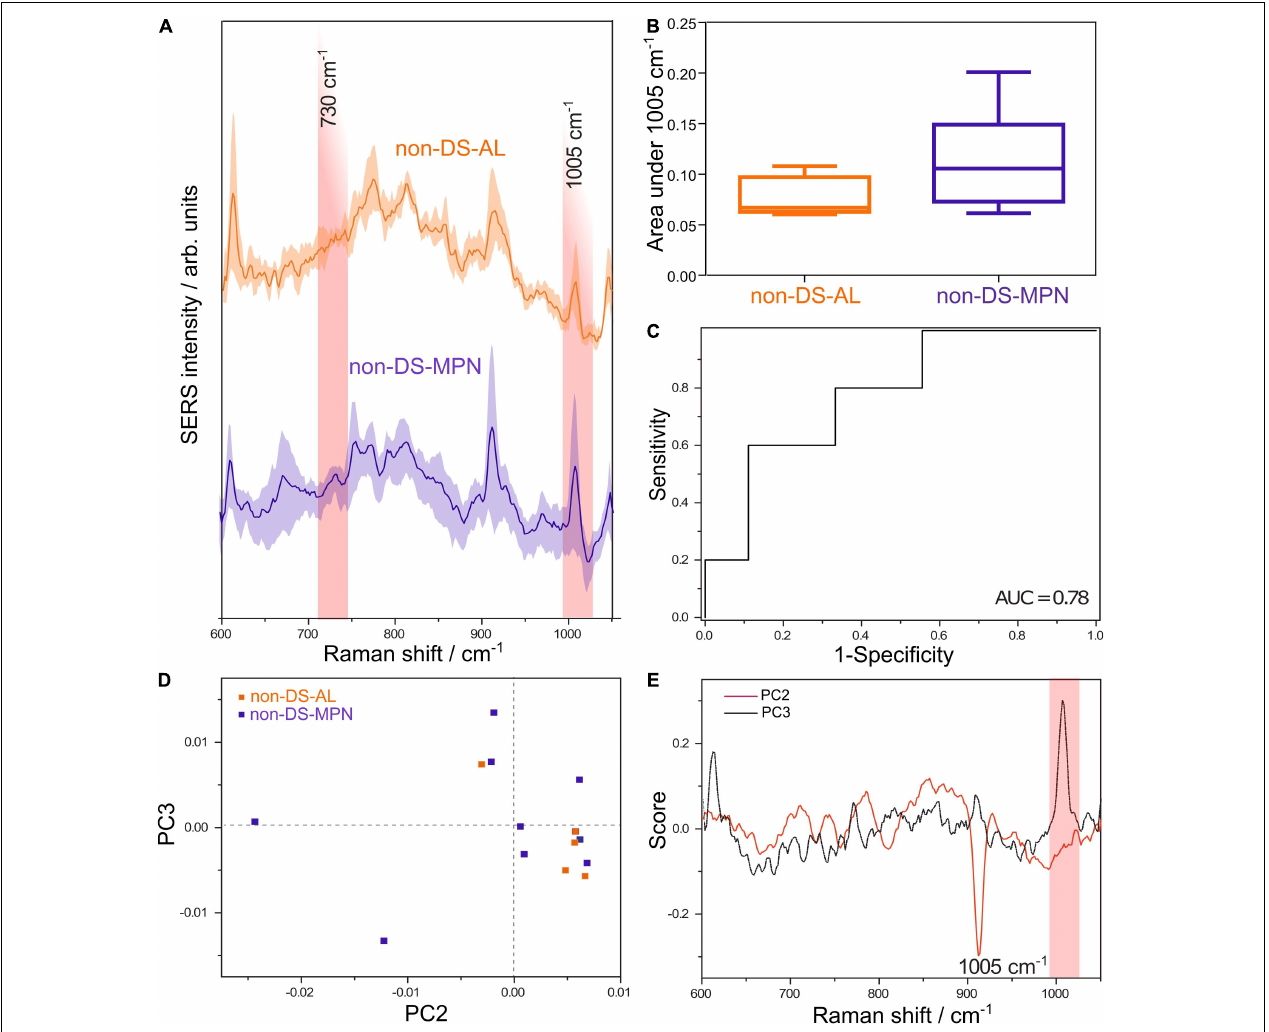
FIGURE 2 | (A) Average SERS spectra of DNA from patients with non-DS-AL and non-DS-MPN. (B) The average normalized area under the SERS band at 1005 cm - 1 attributed to 5-methylcytosine is lower in the non-DS-AL group compared with the non-DS-MPN (one tailed Mann-Whitney U test, p = 0.05). (C) ROC curve for differentiating between non-DS-AL and non-DS-MPN based on the area of the 1005 cm - 1 SERS band, yielding an AUC of 0.78 ( p = 0.09). (D) Score plot of the principal component analysis (PCA) of SERS spectra from non-DS-AL and non-DS-MPN groups. (E) Loading plots corresponding to PC2 and PC3 from the PCA of SERS spectra from non-DS-AL and non-DS-MPN